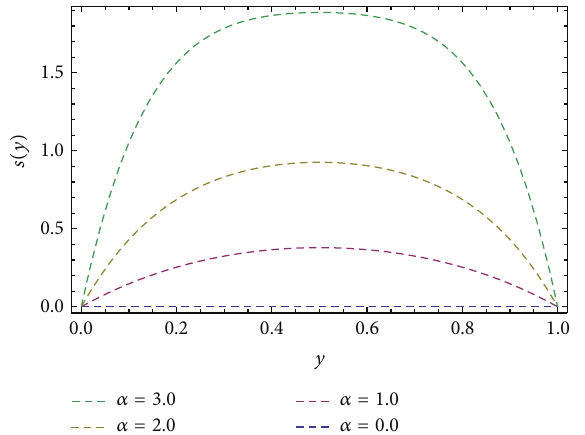
Figure 11: Velocity profile 𝑠(𝑦) for different values of 𝜕𝑃/𝜕𝑧 , keeping 𝛼 = 1.0 , 𝛽 = 1.0 , 𝜕𝑃/𝜕𝑥 = −0.5 , and 𝜙 = 45 ∘ .